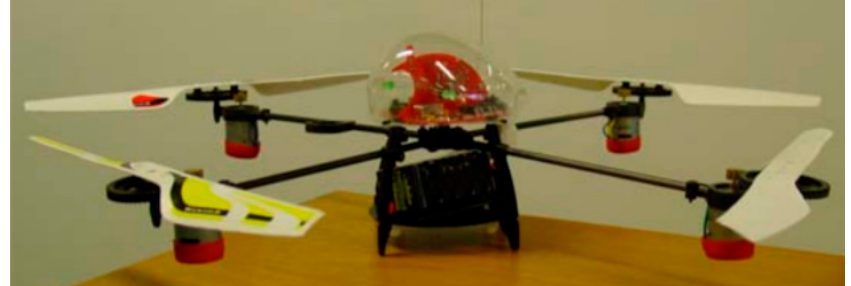
Figure 1. Unmanned Aerial Vehicle (UAV), quadrotor type, model: Draganflyer IV. The equations proposed in this paper for modeling UAV are based on [41].